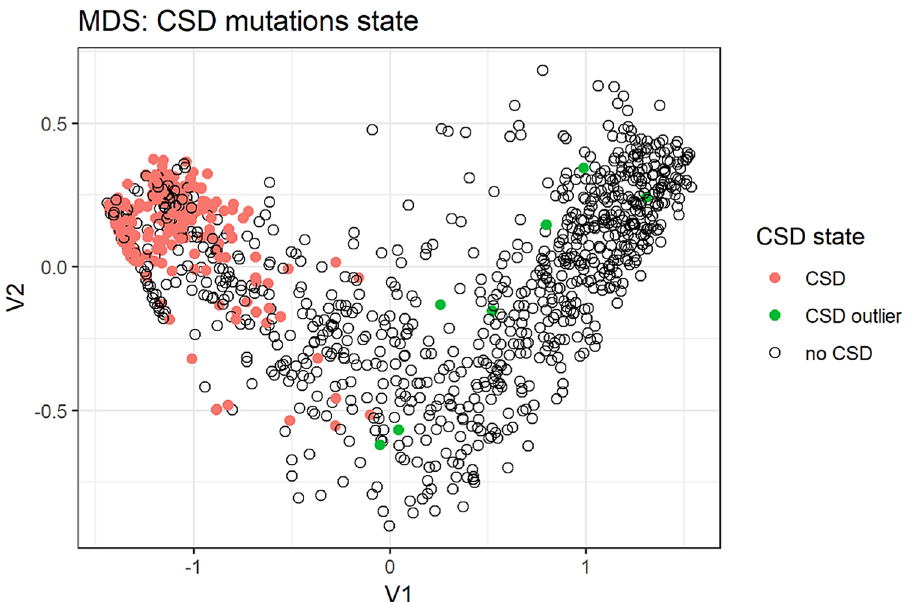
Figure 5. Multidimensional scaling (MDS) for reduction of the 12 activity measures into bidimensional space. CSD, CSD outliers and no CSD mutations are colored red, green and black